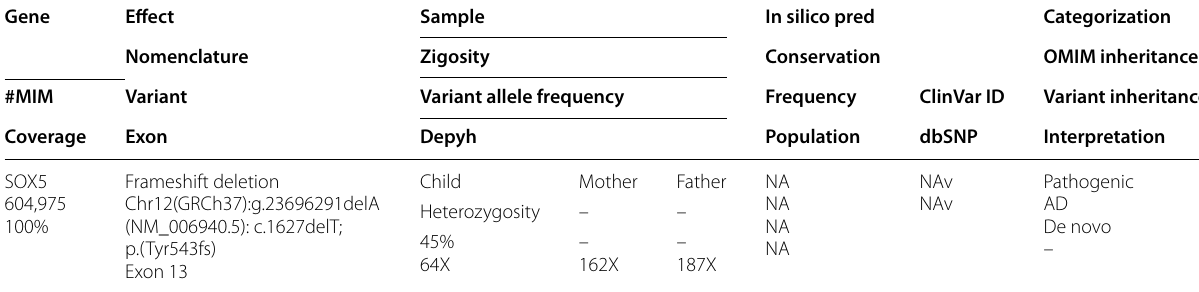
NA not applicable, NAv not available